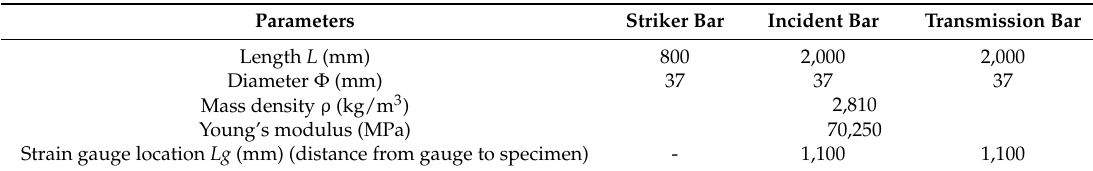
Table 1. The specifications of the SHPB system.